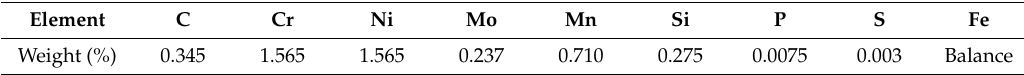
Table 1. Chemical composition of 34CrNiMo6 high strength steel (at. %).